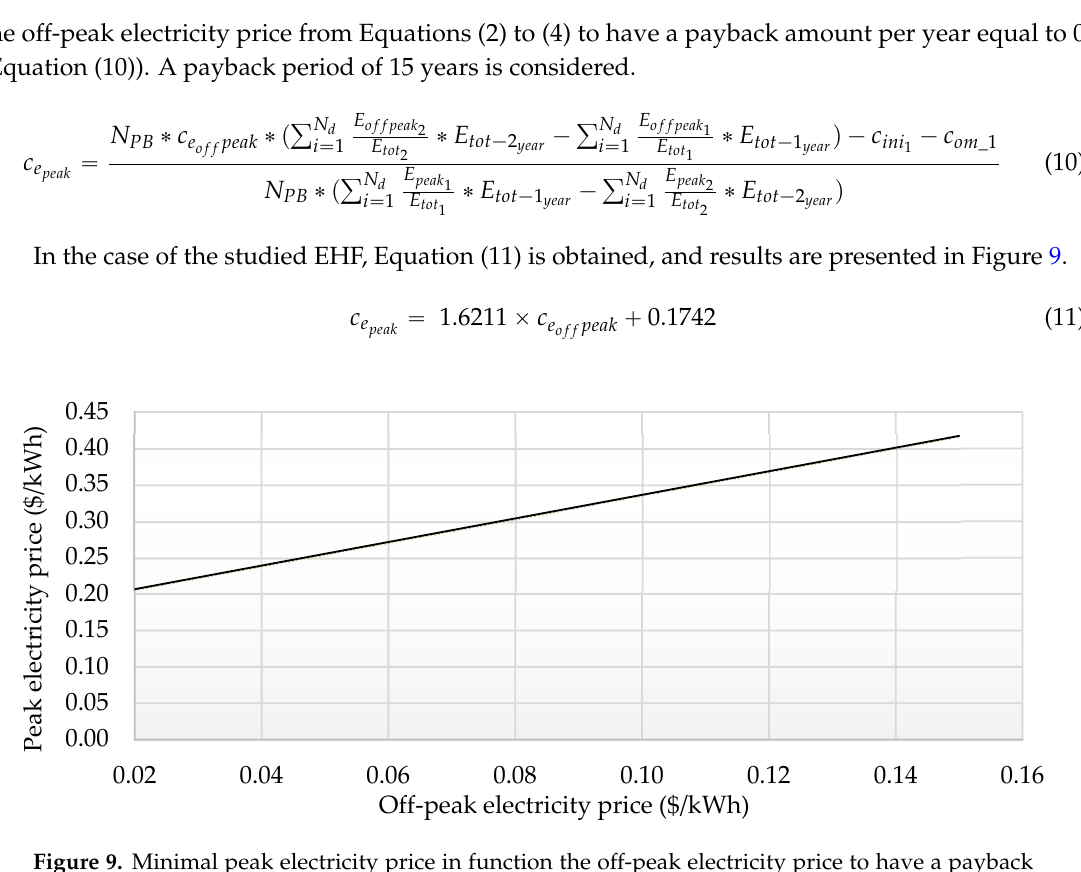
Figure 9. Minimal peak electricity price in function the off-peak electricity price to have a payback period of 15 years.